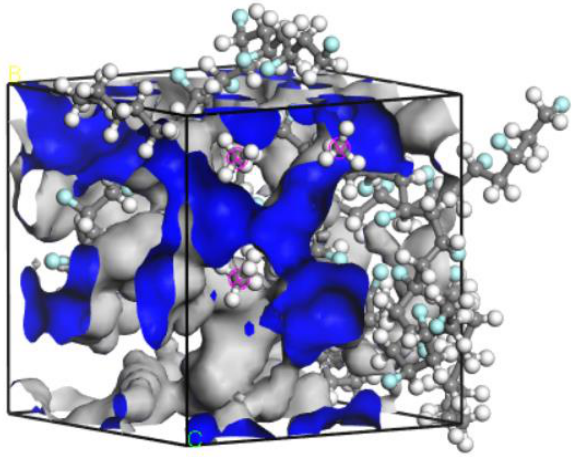
Figure 8. Diffusion coefficient of CH 4 in PVDF at different conditions: ( a ) 2.5MPa, ( b ) 30 °C.